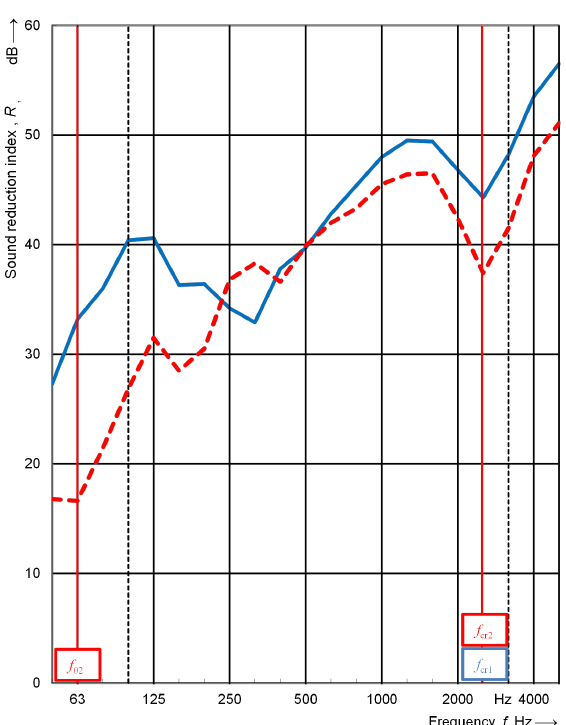
Figure 4. Sound reduction index of walls: timber with recycled infill – the solid blue curve, timber with mineral wool – the dashed red curve.